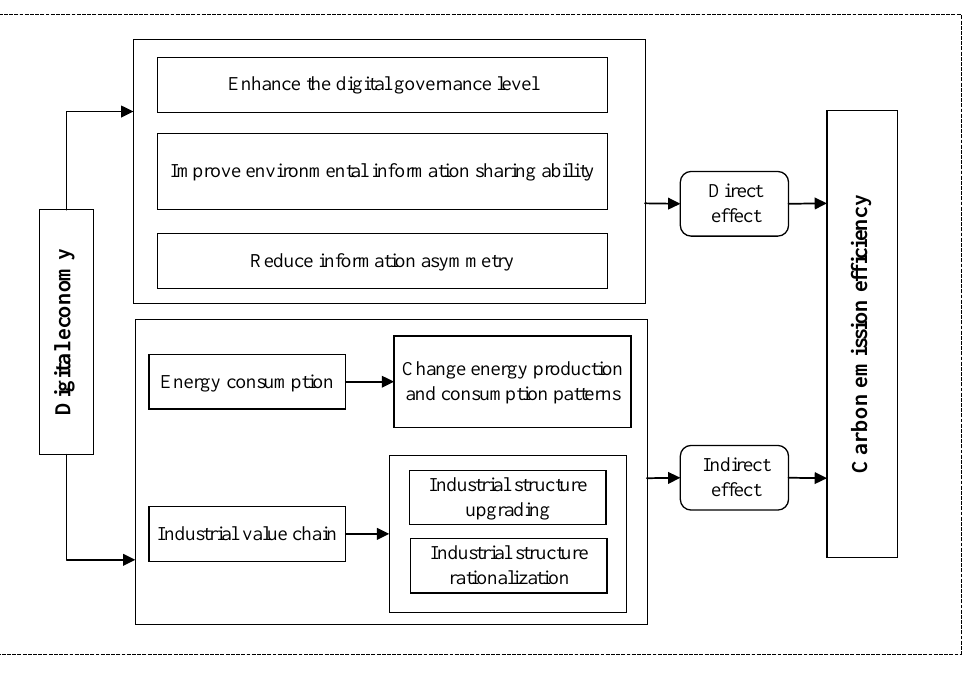
Figure 1. Mechanism analysis between digital economy and carbon emission